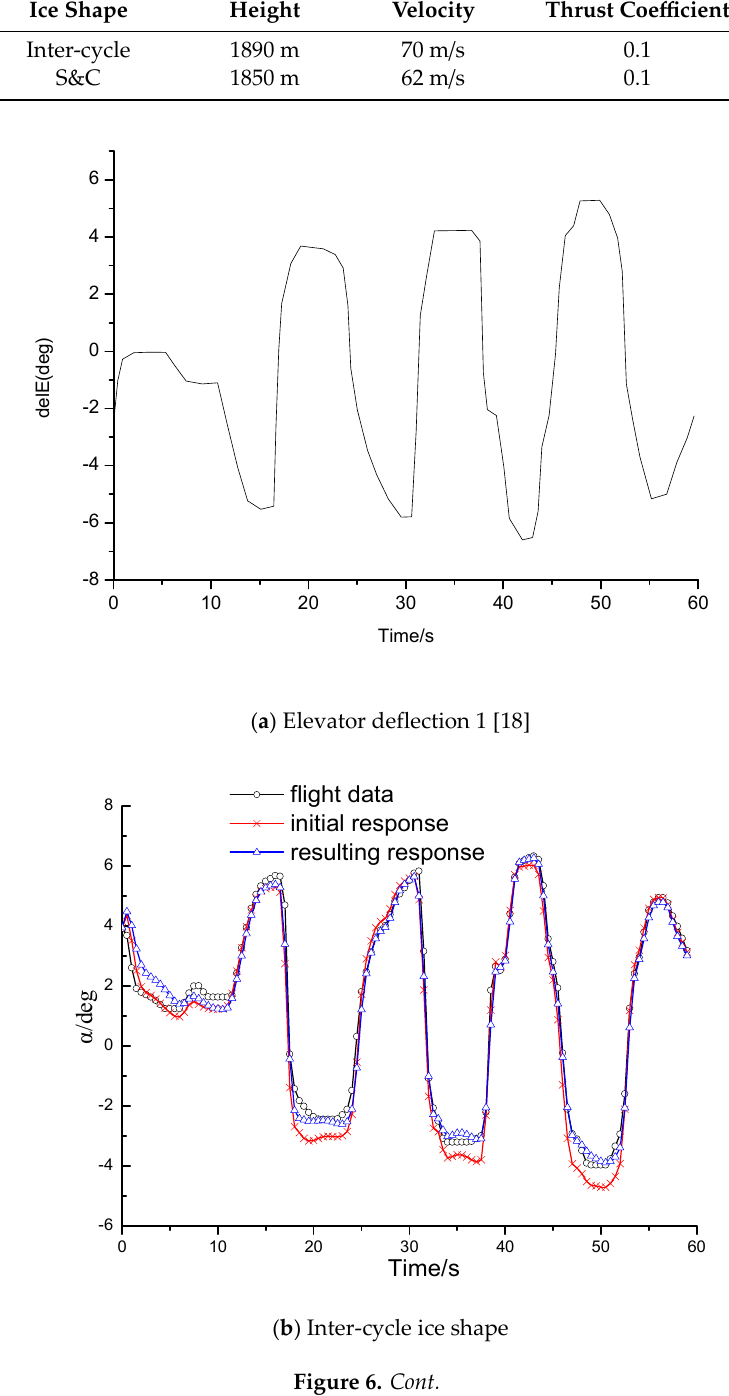
Table 5. Initial flight conditions of horizontal tail iced aircraft